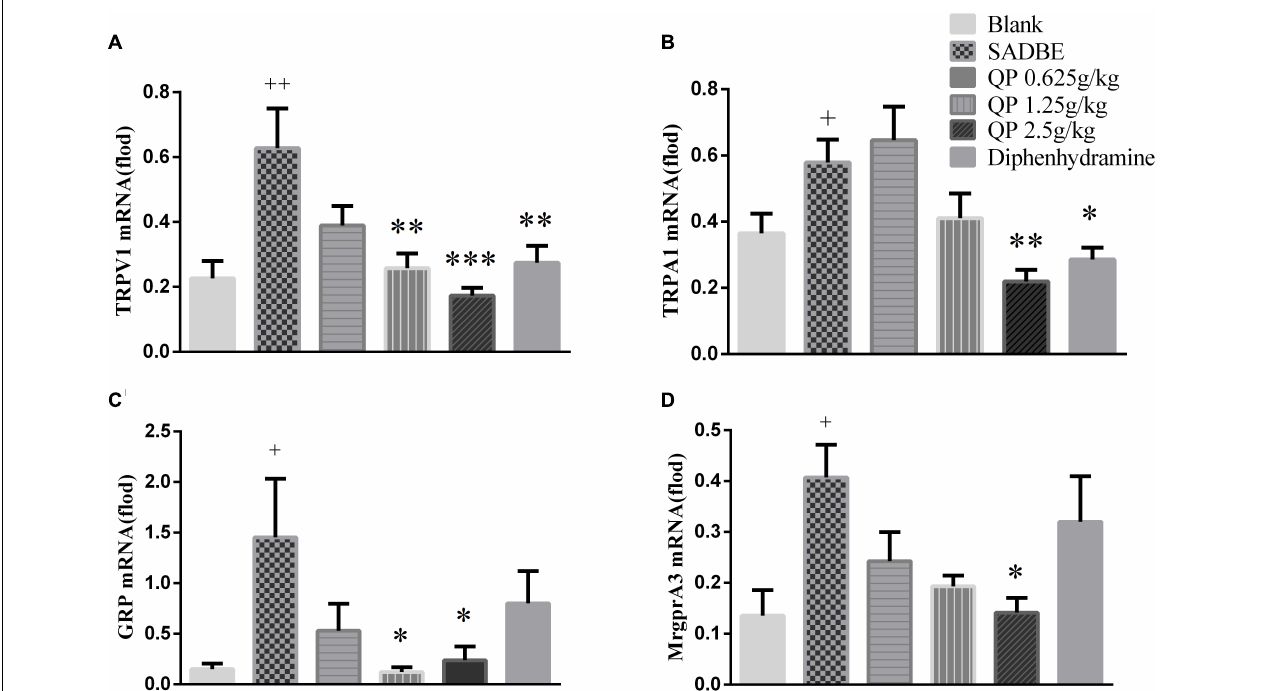
FIGURE 7 | The mRNA of TRPV1 (A) , TRPA1 (B) , GRP (C) and MrgprA3 (D) were detected in mice DRG. After mice were treated with different doses of QP ointment and diphenhydramine, the targeted molecular mRNA levels were measured as well as that in the model group or the blank control group. Data was expressed as mean ± SEM. ∗ p < 0.05, ∗∗ p < 0.01, and ∗∗∗ p < 0.001, compared to the model group. + p < 0.05 and ++ p < 0.01, compared to the blank control group. ANOVA ( n = 5 each group).